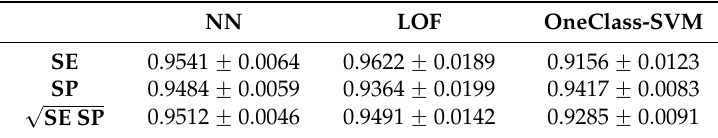
Table 2. Values of SE, SP and their geometric mean for three different novelty detectors. Values are given as means and standard deviations.